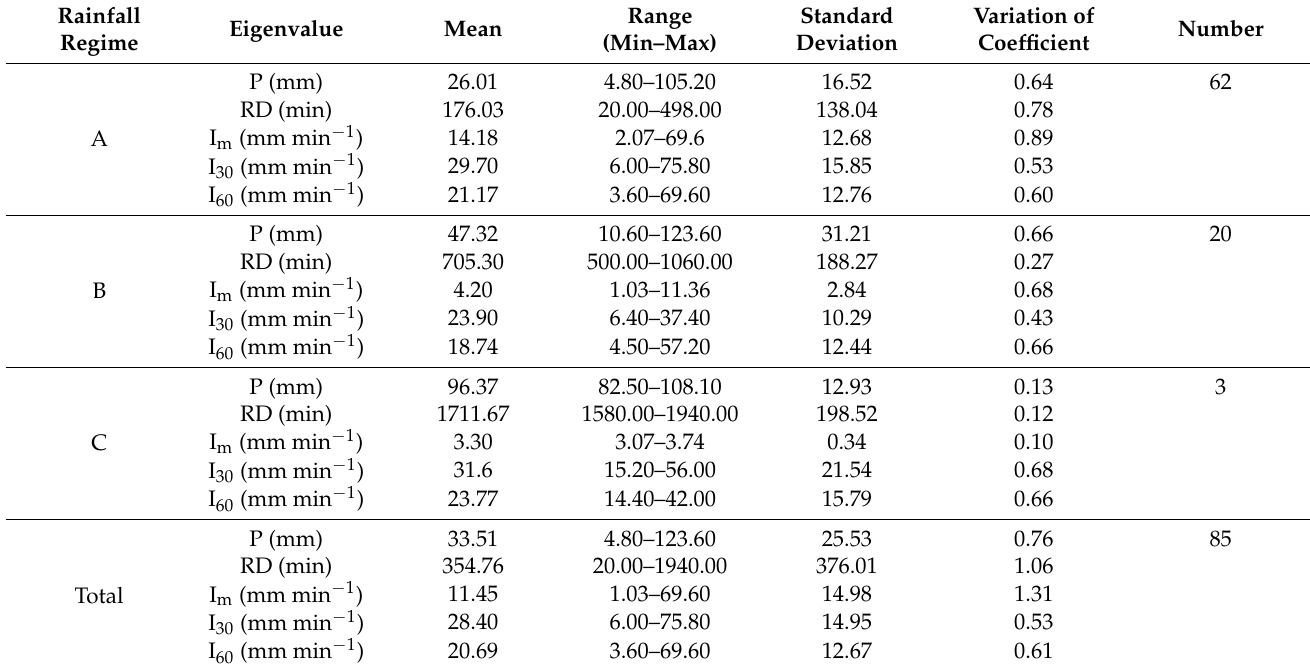
Table 4. Statistical features of the erosive rainfall events separated into three groups based on the rainfall regimes between